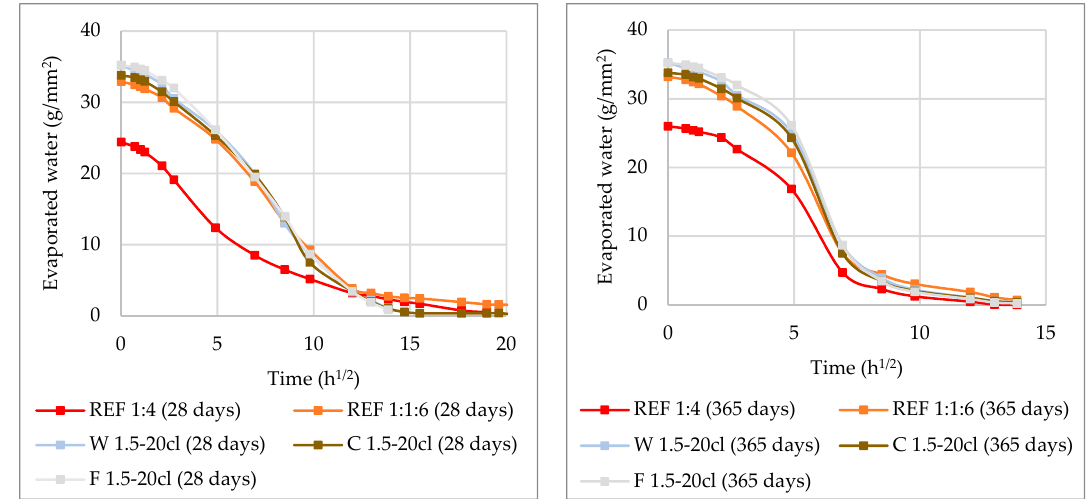
Figure 6. Drying curves of the mortars at 28 and 365 days.